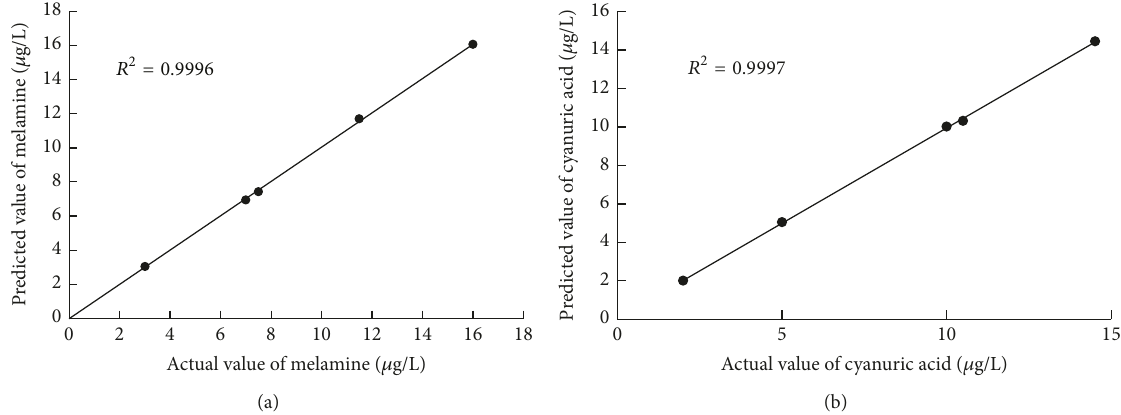
Figure 4: Plots of predicted values versus actual values of infant formula powder with (a) melamine and (b) cyanuric acid in the external validation determined by the PLS1